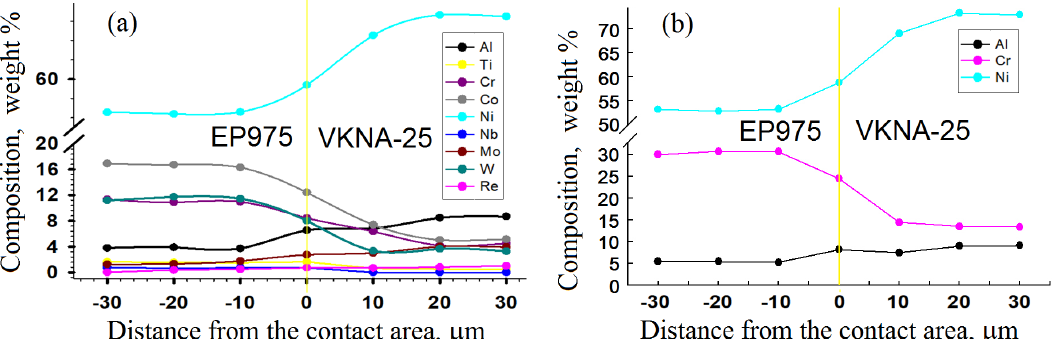
Figure 2. Variations in the composition of alloys near the joint. ( a ) Results of measurements. ( b ) Composition for three groups of elements: the base element Ni, the intermetallic-forming Al and Ti are combined and named Al and all other elements are combined and named